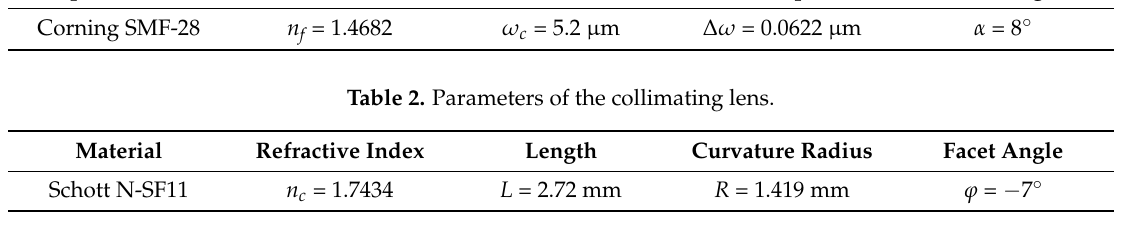
Table 3. Parameters of the MEMS